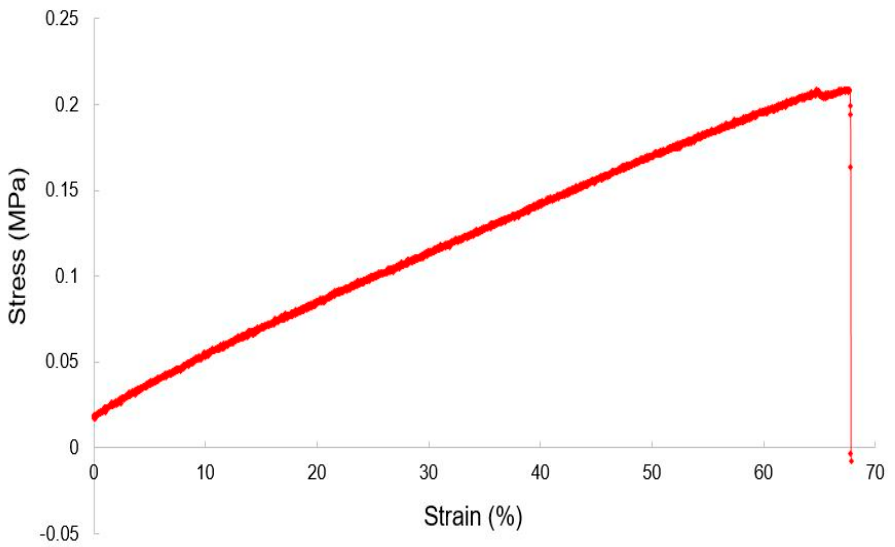
Figure 4. Load-extension relation for the nanocomposite-based sensors.